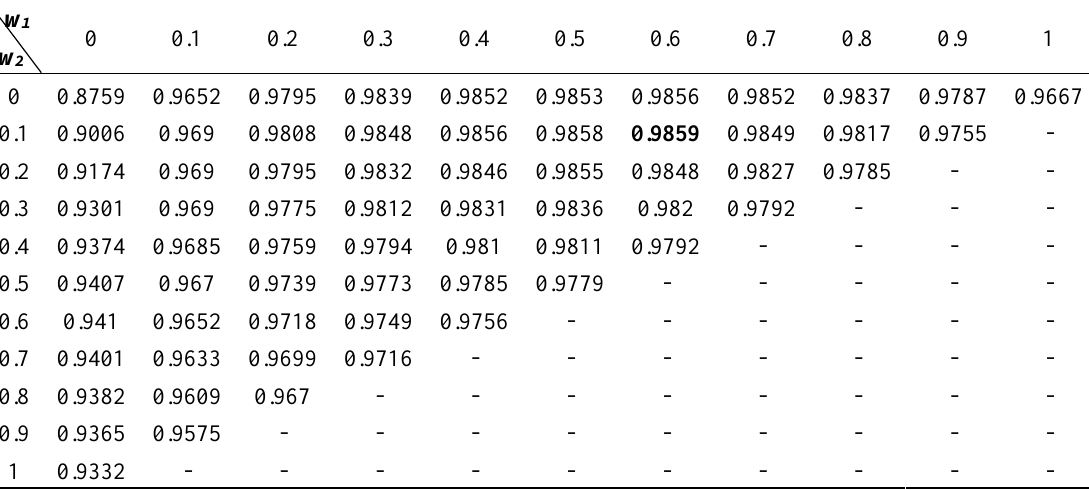
Table 4. Classification accuracy (%) versus the values of Salinas dataset with 30 training samples per class.